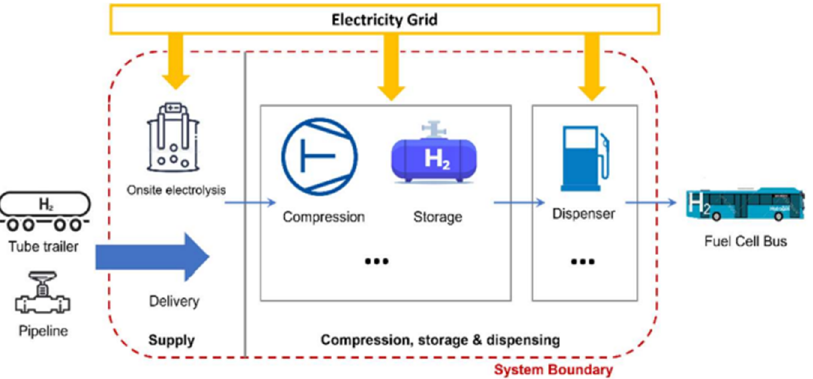
Figure 1. HRS cost model system boundaries Reprinted with permission from Ref. [30]. Caponi, E3S Web of Conferences, 2021. Table 2. Data used as the basis for the scale-up